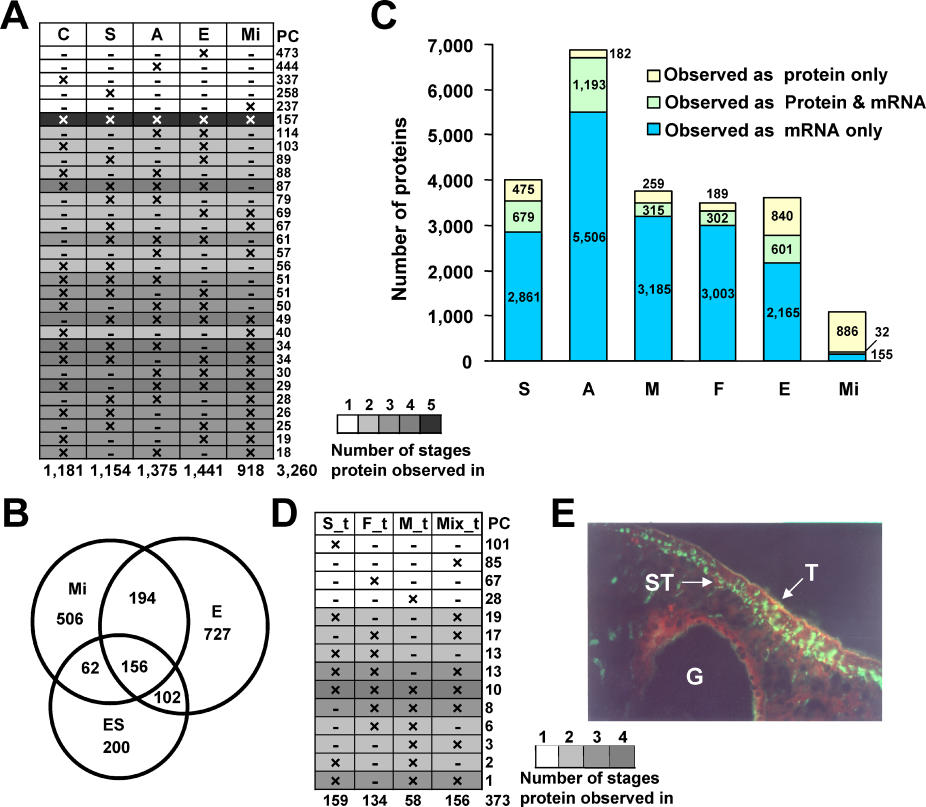
A Comprehensive Proteomic Survey of S. japonicum
(A) Protein expression profiling across the life cycle, including C, cercariae; S, hepatic schistosomula; A, adults; E, eggs; and Mi, miracidia. The numbers on the right side represent the number of proteins observed at the developmental stages indicated to the left. The icon at the bottom indicates the expression pattern during the life cycle, and the numbers indicate the amount of stages in which protein is observed. PC, protein count.(B) Venn diagram of the distribution of observed proteins among E, eggs; Mi, miracidia; and ES, eggshell-containing samples.(C) Comparison of transcriptomic and proteomic data of the developmental stages.(D) Protein expression profiling of tegumental proteins across the life cycles, including S_t , hepatic schistosomula; F_t, female; M_t, male; and Mix_t, mixed-sex adults.(E) The tegumental localization of SjFKBP50 (immunophilin) by immunofluorescence microscopy. T, tegument; ST, subtegument; G, gut.